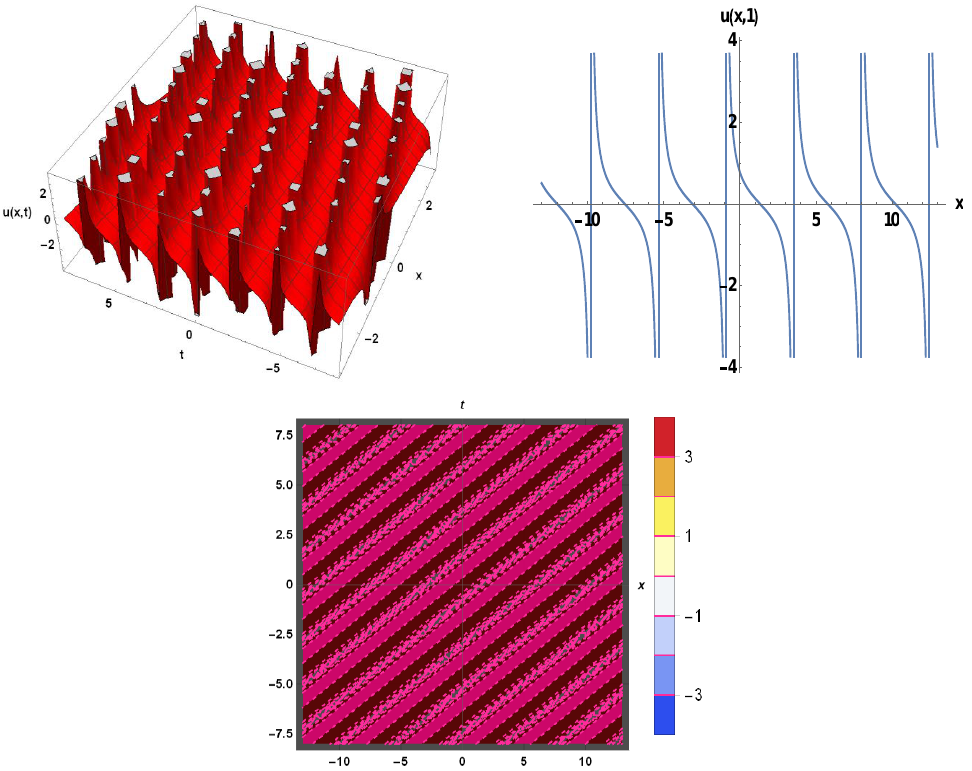
Figure 8. The solitary wave view of the 3D, 2D, and contour plots of U 8 ( x , t ).